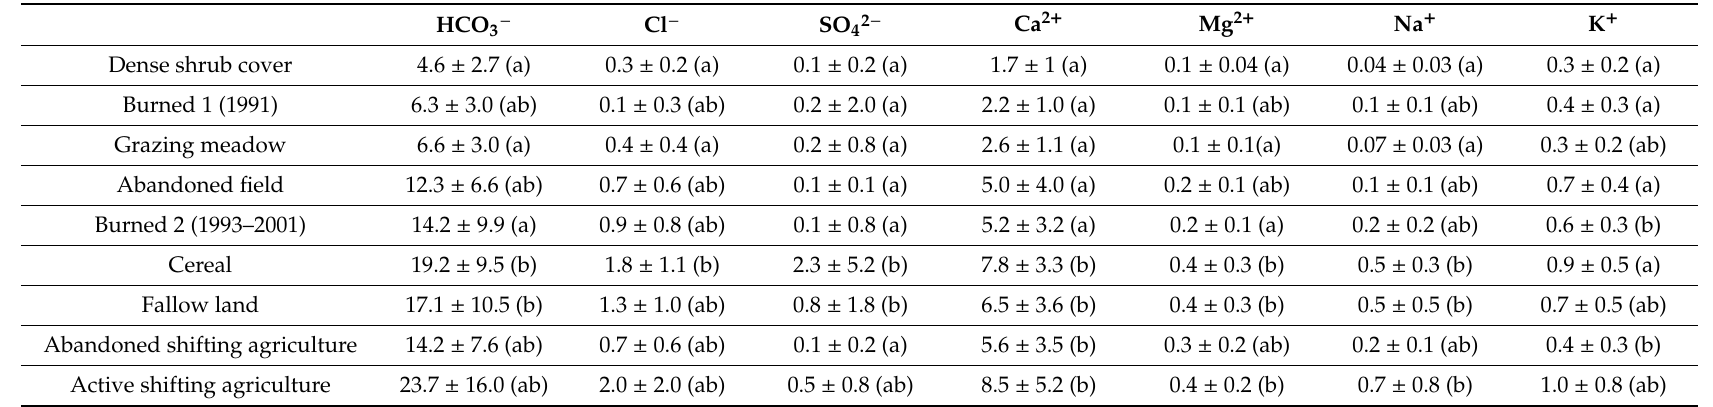
Table 4. Mean and standard deviations of solute losses (g m − 2 ) for the period 1991–2011 (except for abandoned field whose data are from 1992–2011, burned 2 whose data are from 1993–2011 and abandoned shifting agriculture whose data are from 1995–2011). Means with the di ff erent lower-case letter within a column are significantly di ff erent at the 0.05 level of significance ( p <